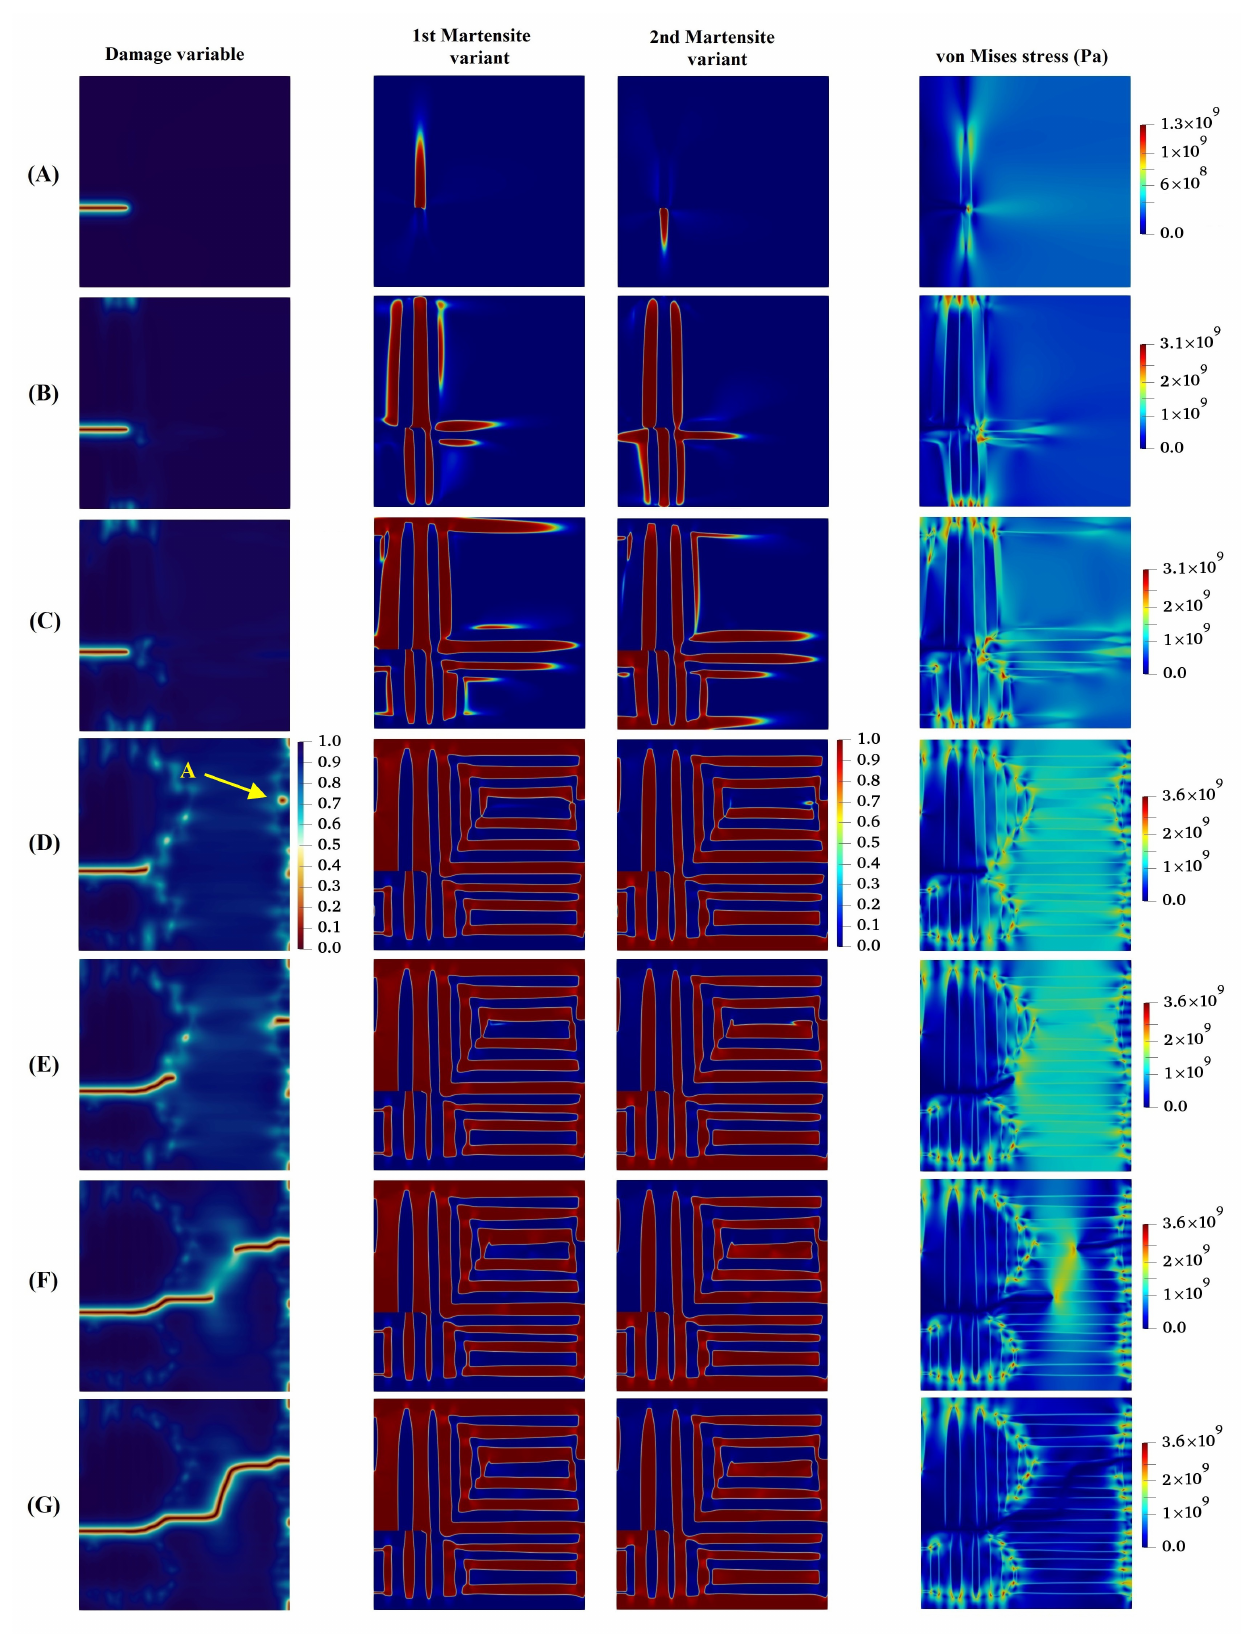
Figure 10. Evolution of damage variable, two martensite variants, and von Mises stress in the austenitic microstructure with crystal lattice orientation of 90°